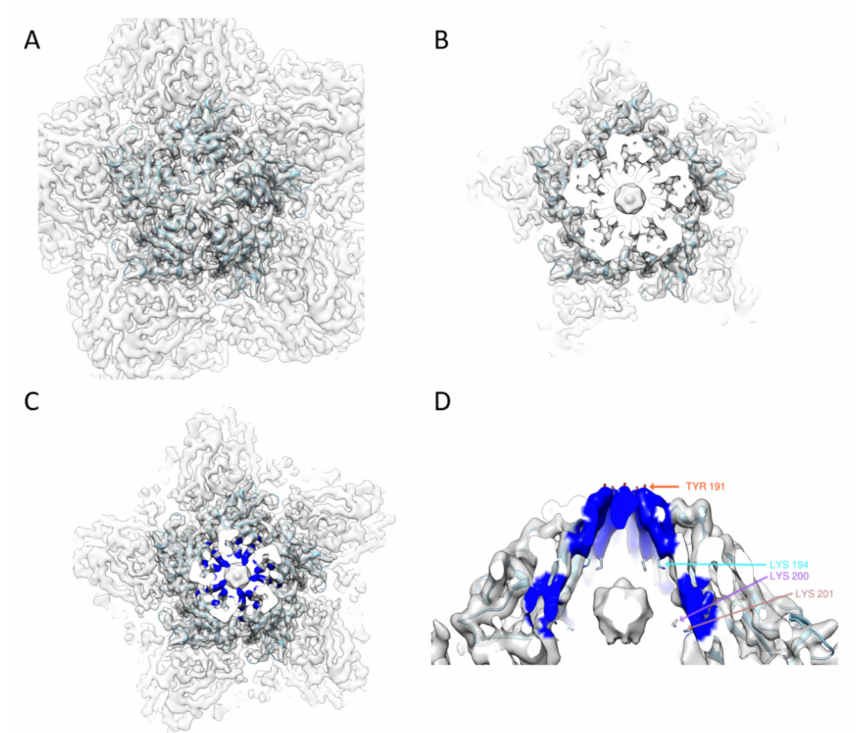
Figure 2. EM density around a five-fold capsomer: ( A ) superposition of the atomic model with the EM map of the TbCSV in one top capsomer; ( B ) the cut-through view of the top capsomer, with the possible DNA density located in the center; and ( C , D ) the top and side views around the center of the capsomer, the positively charged residues (colored in blue) forming a plug (K194) and a double layer ring surrounding the density attributed to DNAs.